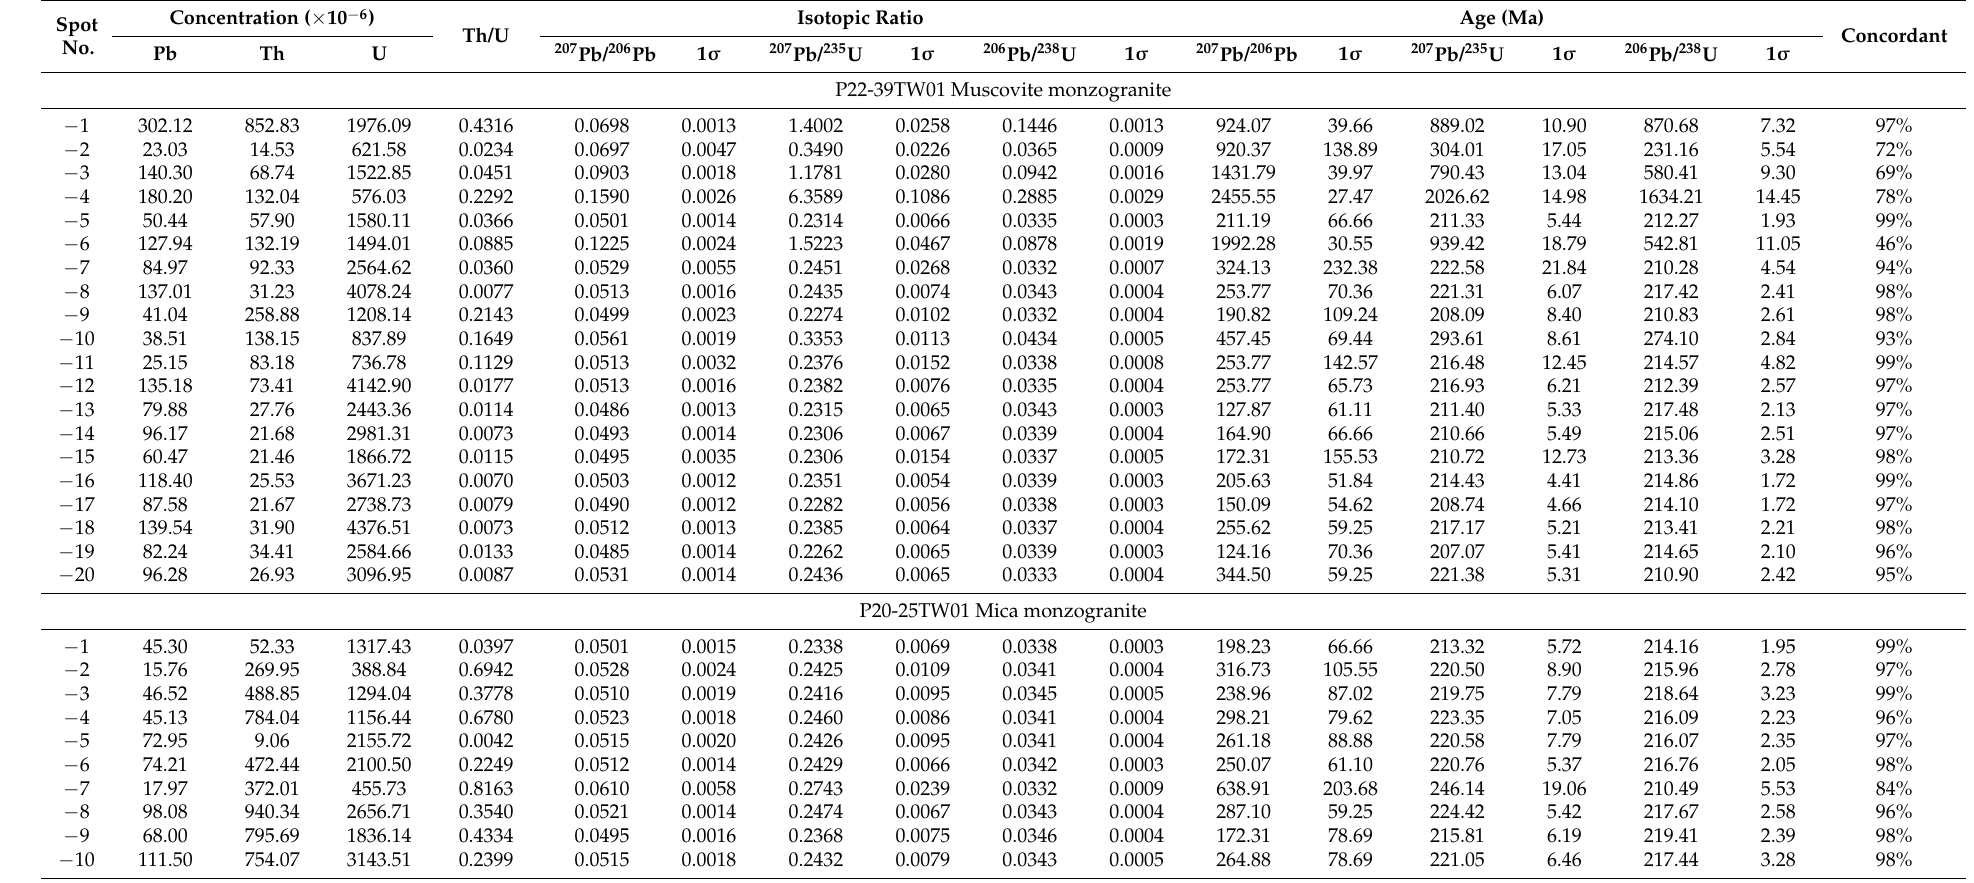
Table 3. Zircon LA–ICP–MS U– Pb isotope analysis results of the Dahongliutan